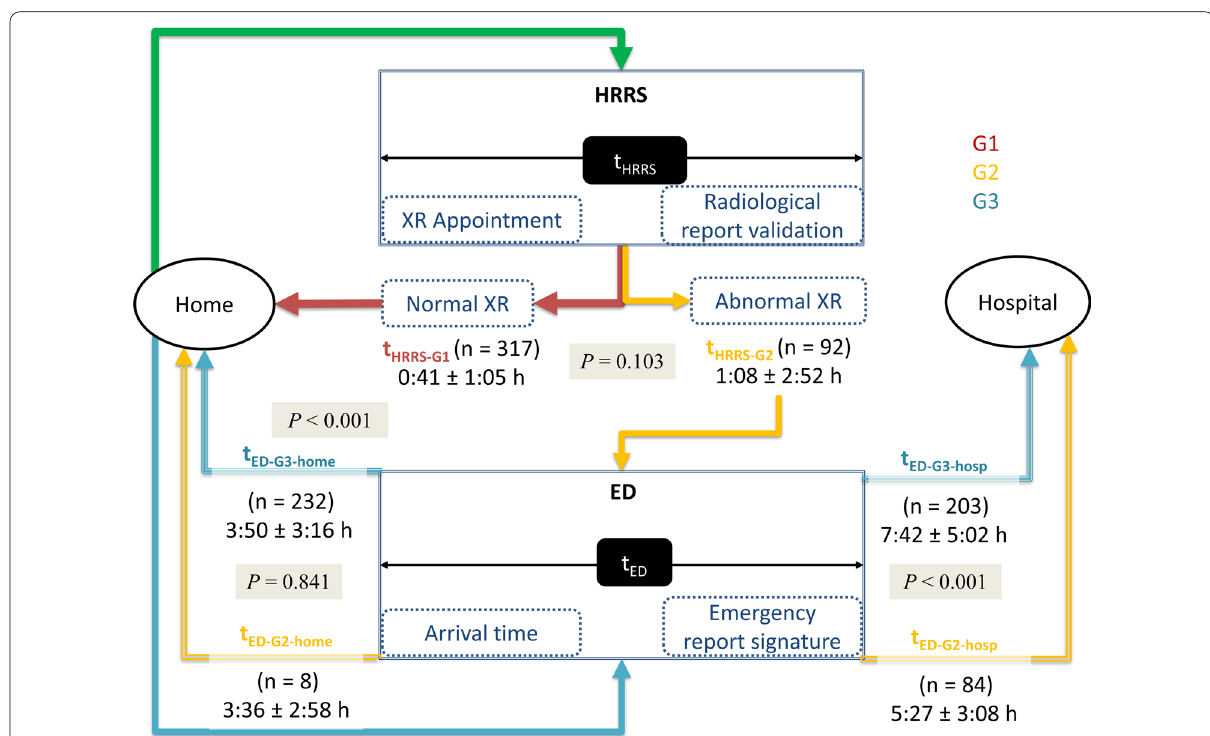
Fig. 4 Differences in the process length in each clinical group (G). Decision for G1 patients was always discharge; for G2 and G3 patients could be discharge (home) or hospital admission (hosp). Time length in G1 was always shorter than in G3, regardless of whether G3 patients could return home. Time length in G2 was always shorter than in G3, whatever the decision, even when t pcHRRS was added to the t ED , except for the 9 patients arriving from the pcHRRS who were finally discharged. The process length for most G2 patients was probably shorter since the emergency physicians were notified immediately about the X-ray findings. In those cases, the validation of the radiological report was often delayed,